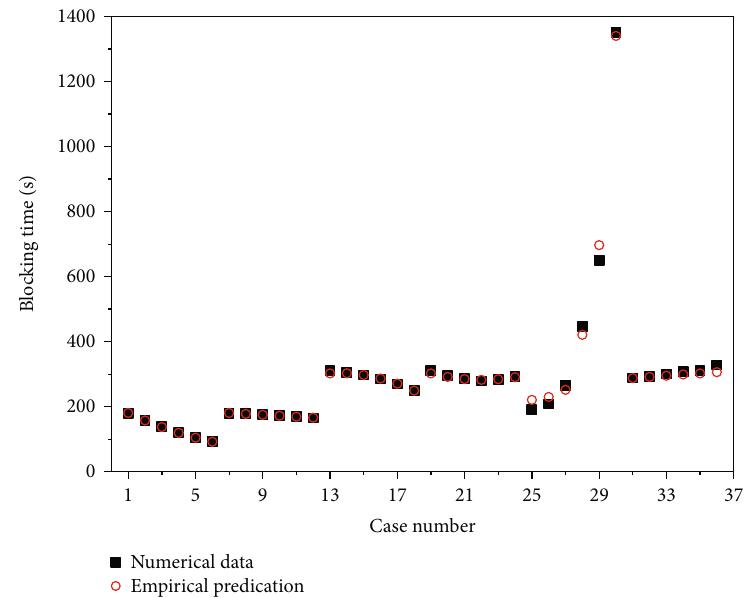
Figure 17: Comparison of numerical data and results calculated via the proposed equations for a pitot